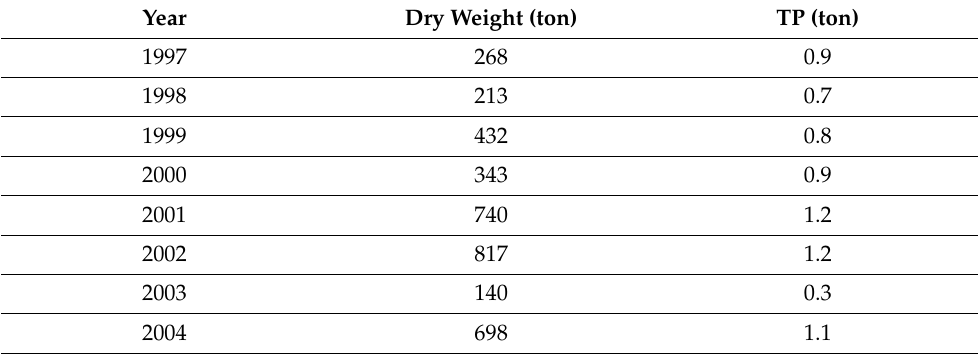
Table 5. Annual averages of the total vegetation load of dry weight and TP (ton) for the entire lake during the period of 1997–2004 [22].